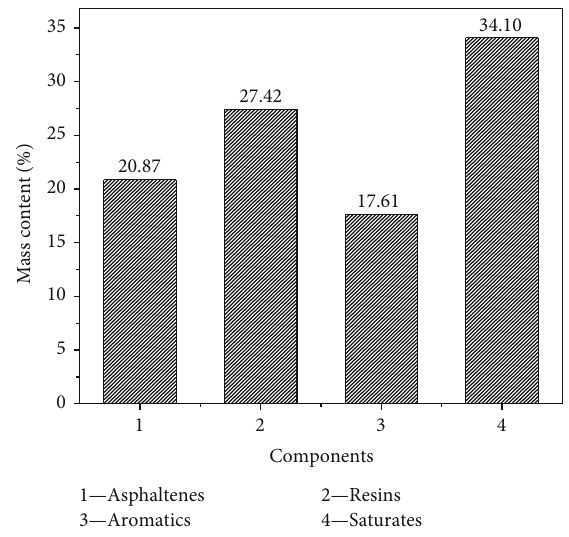
Figure 6: Separation of Karamay bitumen into four